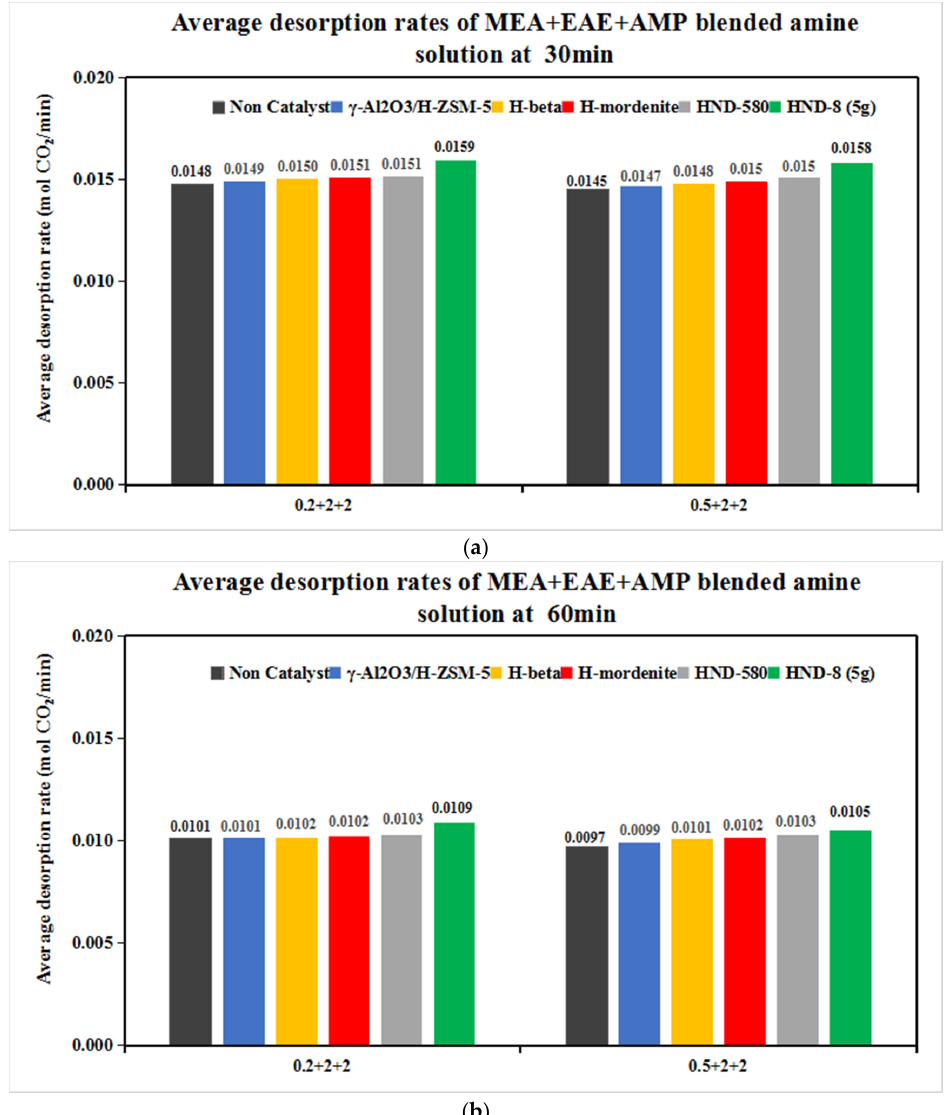
Figure 5. The average desorption rates of MEA + EAE + AMP with catalysts at ( a ) 30 min and ( b ) 60 min.